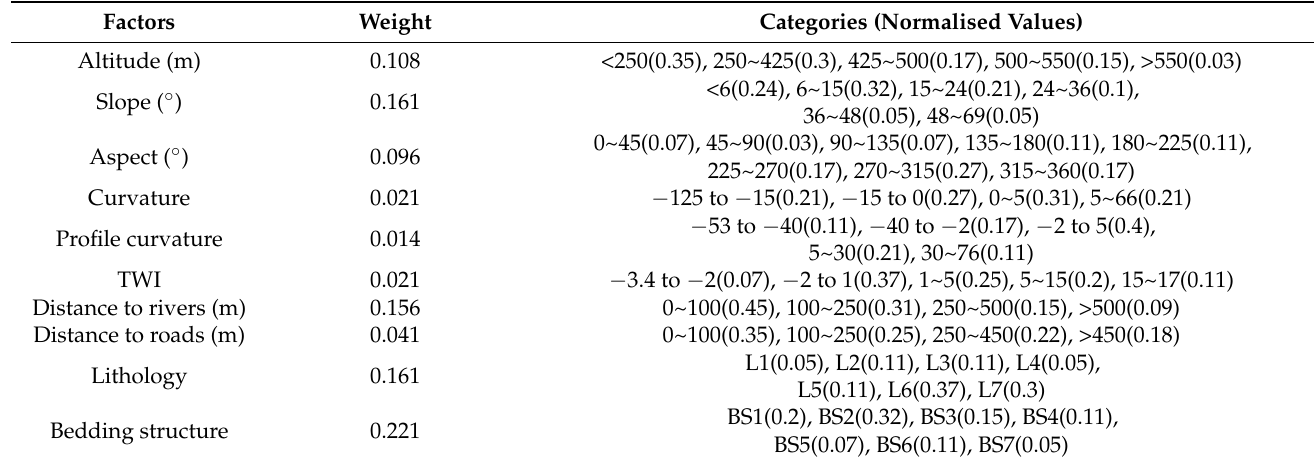
Table 4. Description of 10 causal factors and grade scores of variables in AHP model.